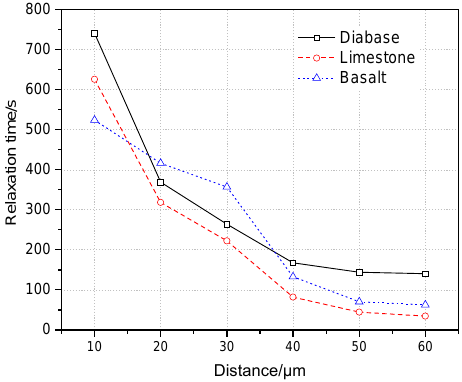
Figure 12. Relaxation time distribution in the interfacial zone.